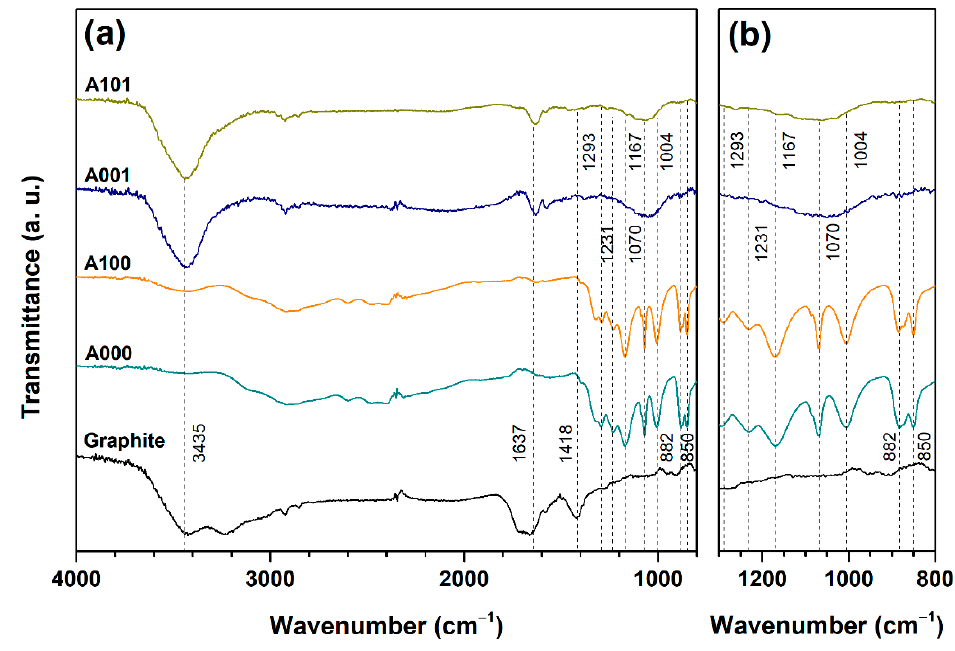
Figure 7. FTIR spectra of GBS products obtained using (NH 4 ) 2 S 2 O 8 oxidizing agent in the region of 4000–800 cm − 1 ( a ) and 1300–800 cm − 1 ( b ).